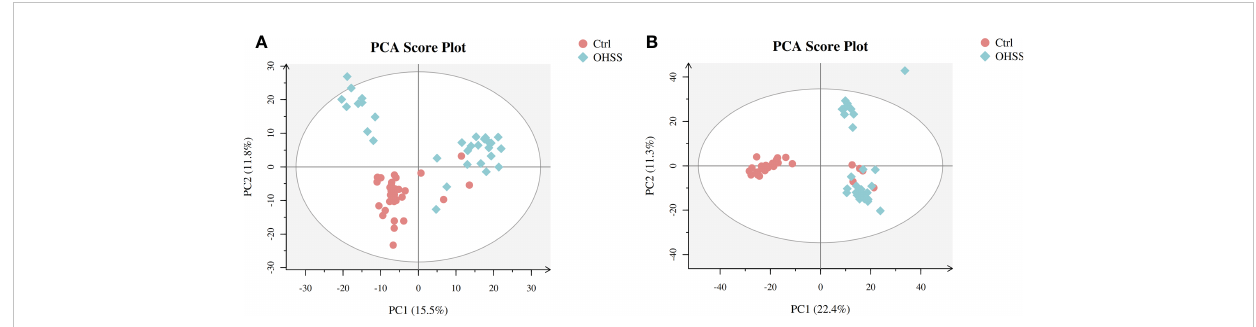
FIGURE 1 PCA score plots of the control and OHSS groups based on follicular fl uid spectral data. Follicular fl uid metabolomics pro fi les examined by PCA demonstrated a differentiation between the control and OHSS groups. Score plot of the fi rst two principal components (PC1, PC2) from PCA model obtained when comparing the control group and OHSS group: (A) ESI positive mode; (B) ESI negative mode. One point stands for one subject, red circles represent the control, blue diamonds represent